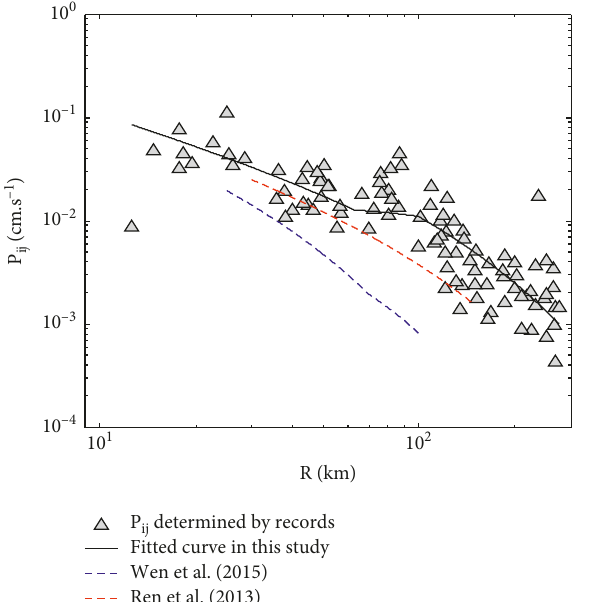
Figure 8: Distribution of P ij (f) versus hypocentral distance.